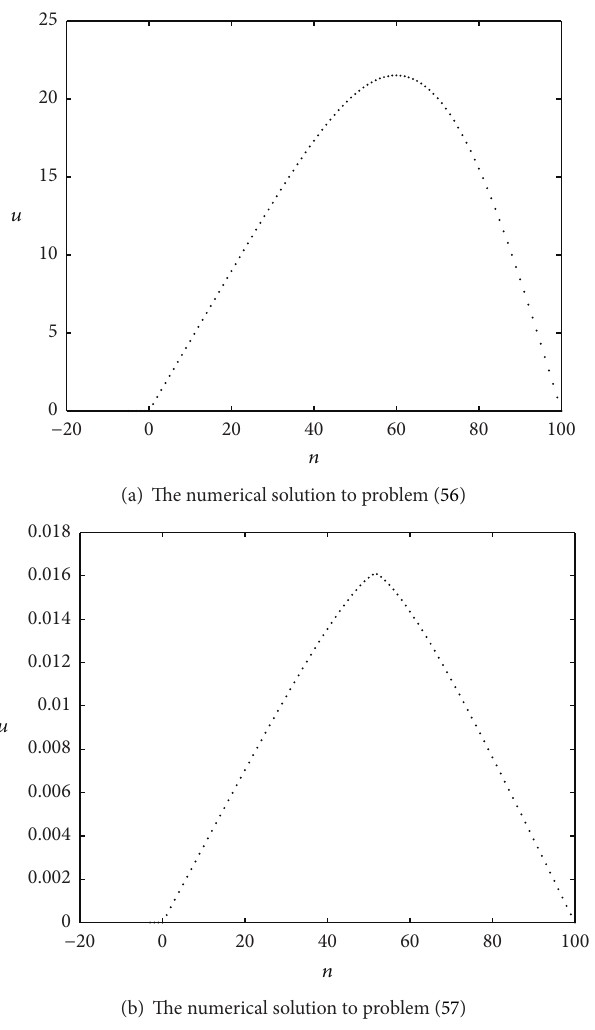
Figure 1: The figures of the numerical